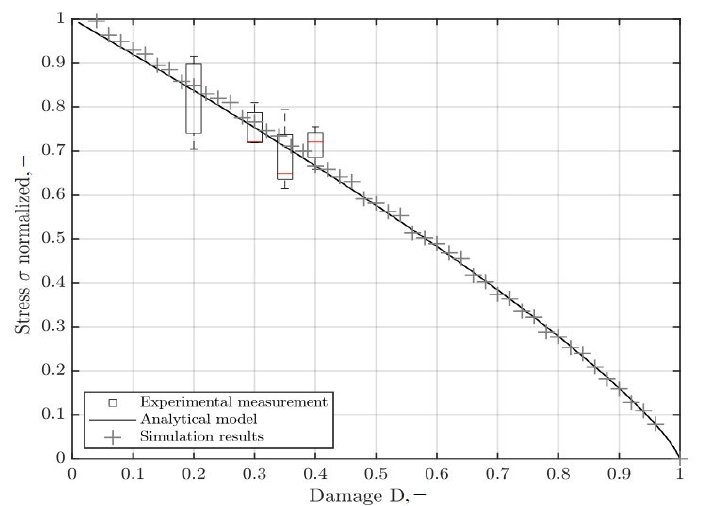
Figure 8. Comparison of the stress–strain curve with various damaged specimens in 0° orientation.